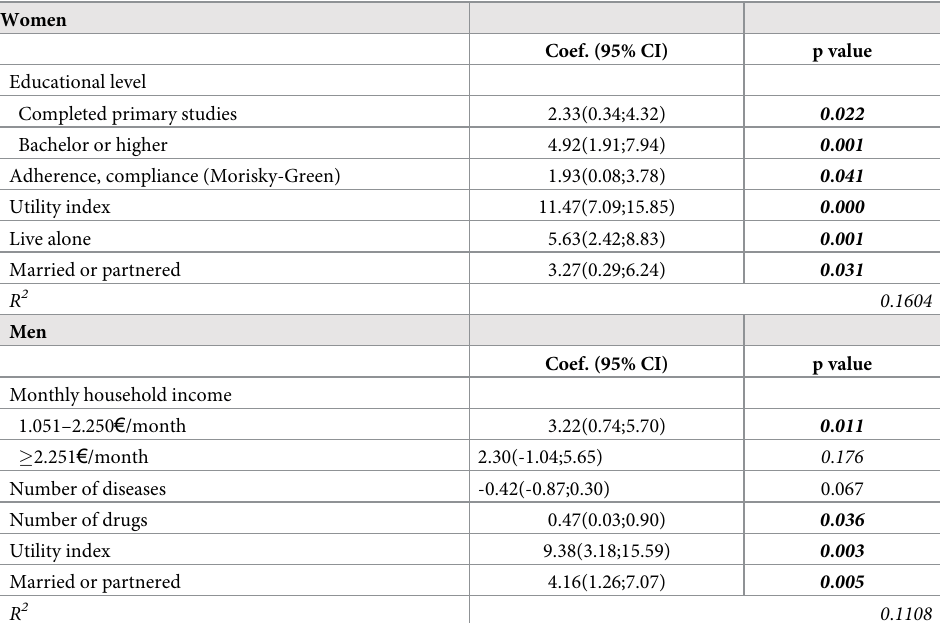
Table 4. Factors associated with functional social support in women and